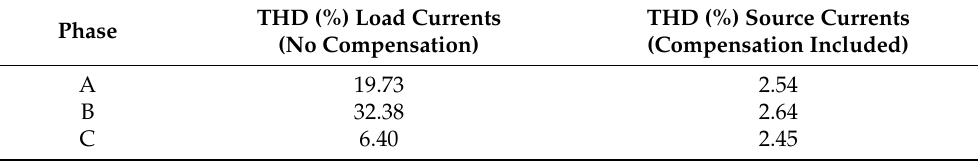
Table 2. THD Comparison before and after compensation.